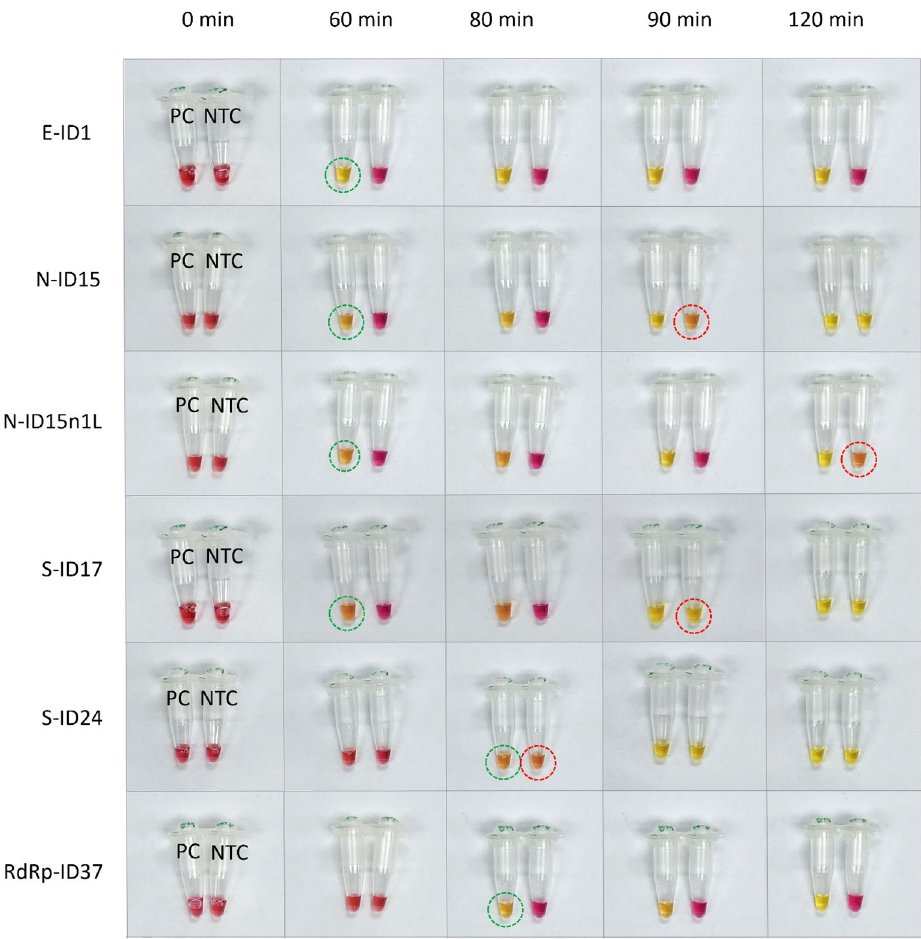
Figure 7. Colorimetric test using all primer sets, each containing five primers (F3, B3, FIP, BIP, and LB) on Omicron positive controls (PC) and non-template controls (NTC). All primer sets show a higher tolerance for longer reaction times before producing misamplifications compared to using the same primer sets with six primers (Fig. 1). However, N-ID15, N-ID15n1L, S-ID17, and S-ID24 primer sets (without the LF primer) still produced misamplifications in NTC between 90 and 120 min. Reversely, the false-positive amplification was not evident by using the E-ID1 and RdRp-ID37 primers even up to 120